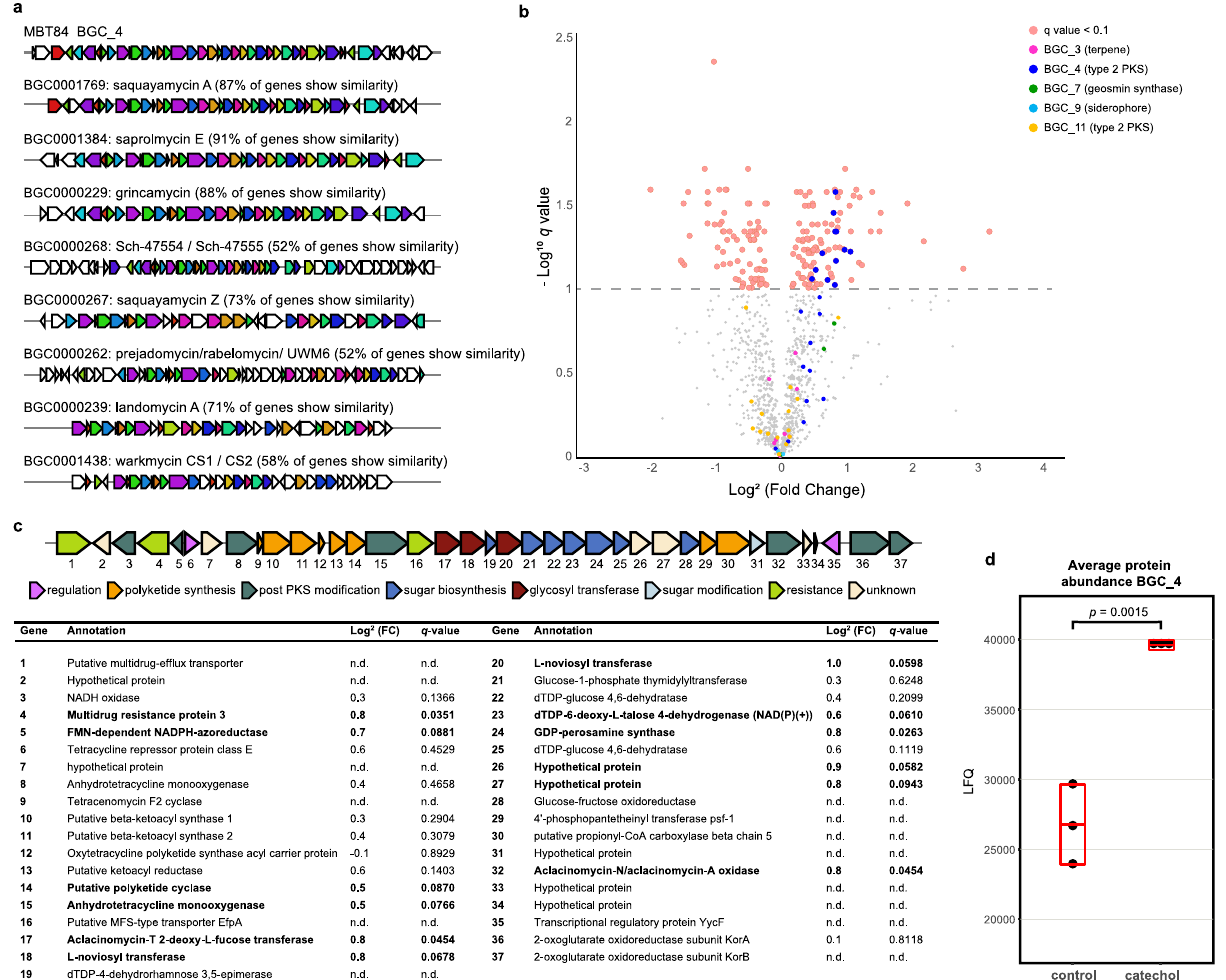
Fig. 5 Identi fi cation of the BGC responsible for the production of angucycline glycosides in Streptomyces sp. MBT84 using antiSMASH and MS-based quantitative proteomics. a KnownClusterBlast output from antiSMASH which shows similar clusters from the MIBiG database. Genes marked with the same color are interrelated; white genes have no relationship. b Volcano plot of MS-based quantitative proteomics for cultures grown with and without catechol ( n = 3). Proteins with an FDR-adjusted p -value ≥ 0.1 are grayed out. Proteins with a positive log 2 fold change are higher expressed in catechol- grown cultures. c BGC4 coding for the biosynthesis of angucycline glycosides. Annotations are based on BLAST homology searches and genes are color- coded based on putative function. Signi fi cantly differentially expressed proteins are depicted in bold (FDR-adjusted p < 0.1, two-sample t -test, n = 3). d Average protein level of BGC4 of cultures grown with and without catechol ( n = 3). Mean and standard deviation are indicated in red. Two sample t -test was done showing BGC4 is signi fi cantly differentially expressed in presence of